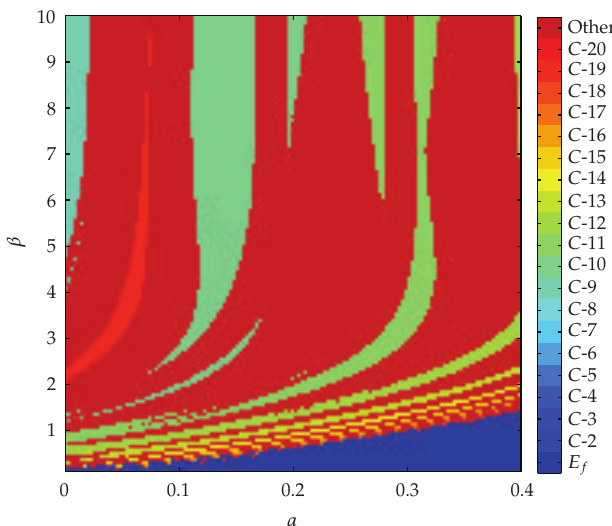
Figure 7: Two-dimensional bifurcation diagram in parameters’ plane (cid:2) a,β (cid:3) for i.c. x 0 (cid:9) 0 . 8, m 0 (cid:9) w 0 (cid:9) 1. The other parameter values as in Figure 5.